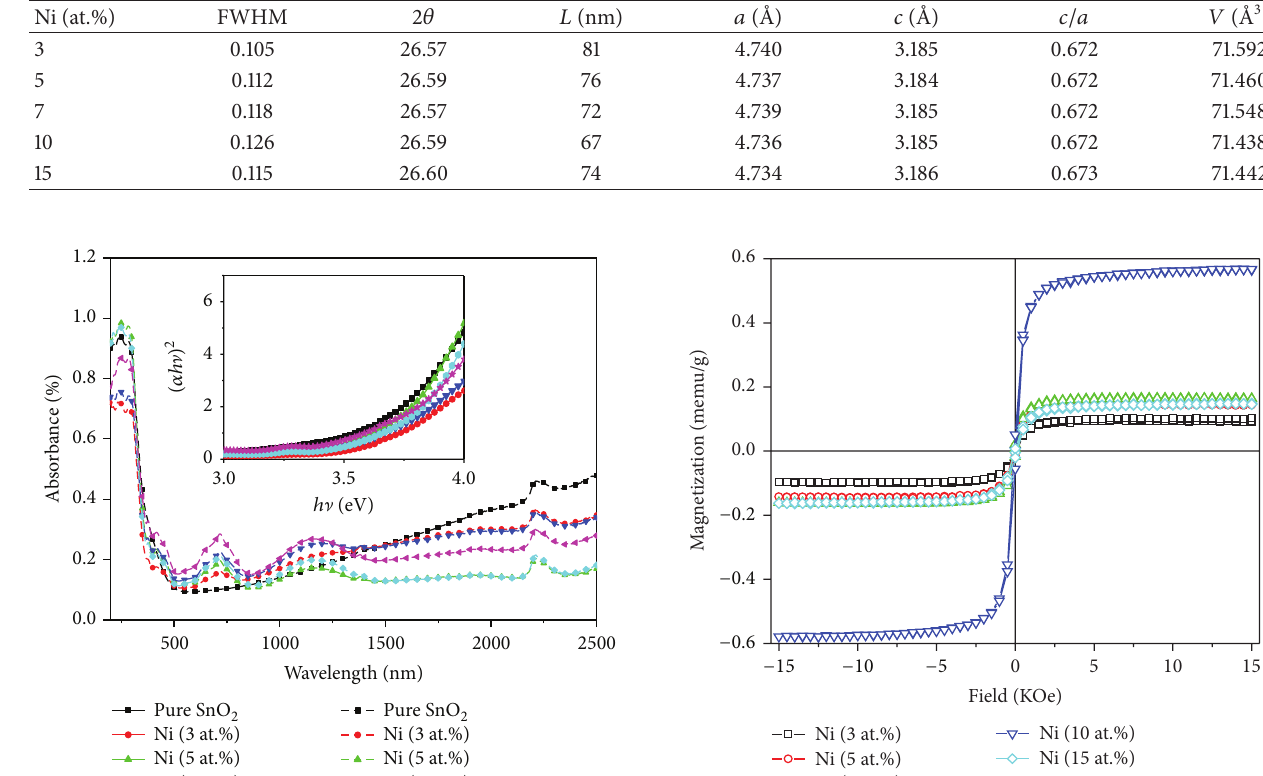
Table 1: Summary of doping concentrations (at.%), FWHM, 2𝜃 (1 1 0) from XRD, grain size ( 𝐿 ), lattice parameters, tetragonal distortion ( 𝑐/𝑎 ), and unit cell volume ( 𝑉 ) of Ni doped SnO Ni (at.%)